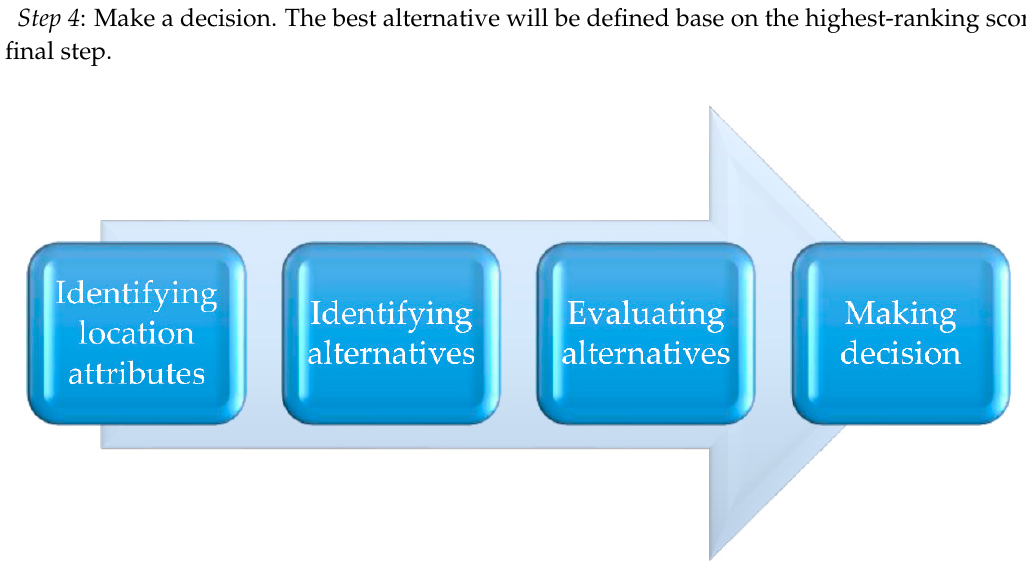
Figure 2. General methodology of location selection problem.